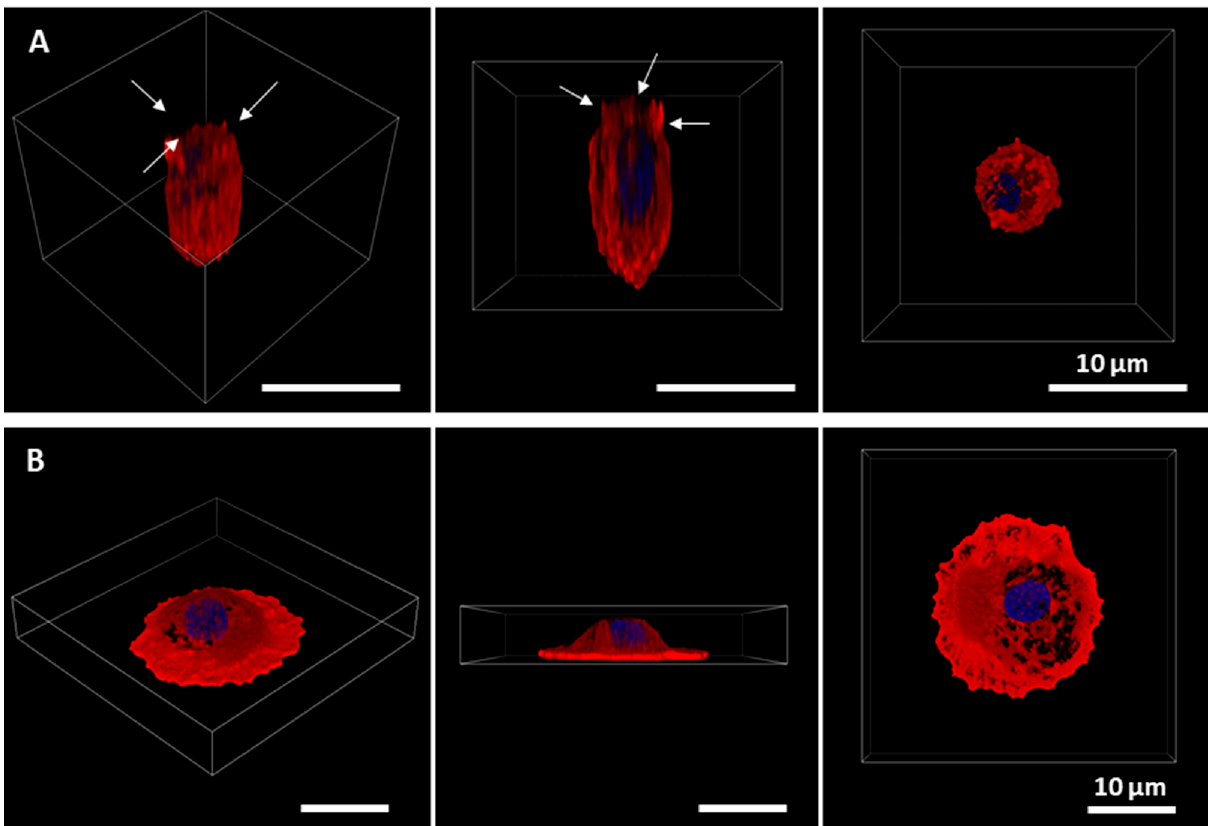
Figure 2. Three-dimensional representation of primary alveolar type II cells cultured for three days on hydrogel ( A ) and on a plate ( B ). Nuclei are stained in blue and actin cytoskeleton in red. In the case of the hydrogel-cultured cell, it can be distinguished by a cuboidal morphology and the presence of microvilli, indicated by arrows. In the case of the cell cultured on a plate, a more spread out and wider cytoplasm can be observed showing increased size.